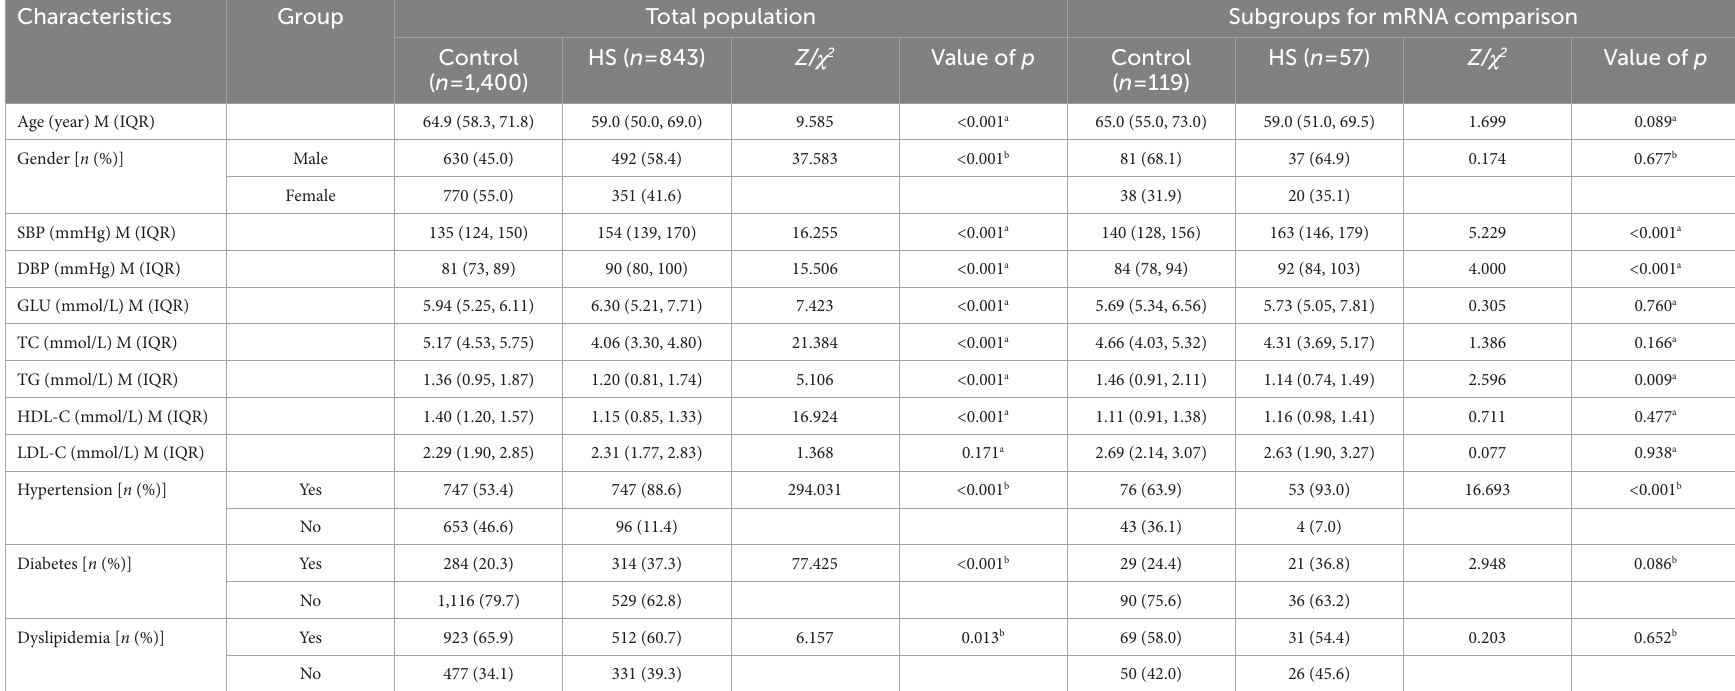
TABLE 1 Demographic and clinical characteristics of the subjects in the case–control